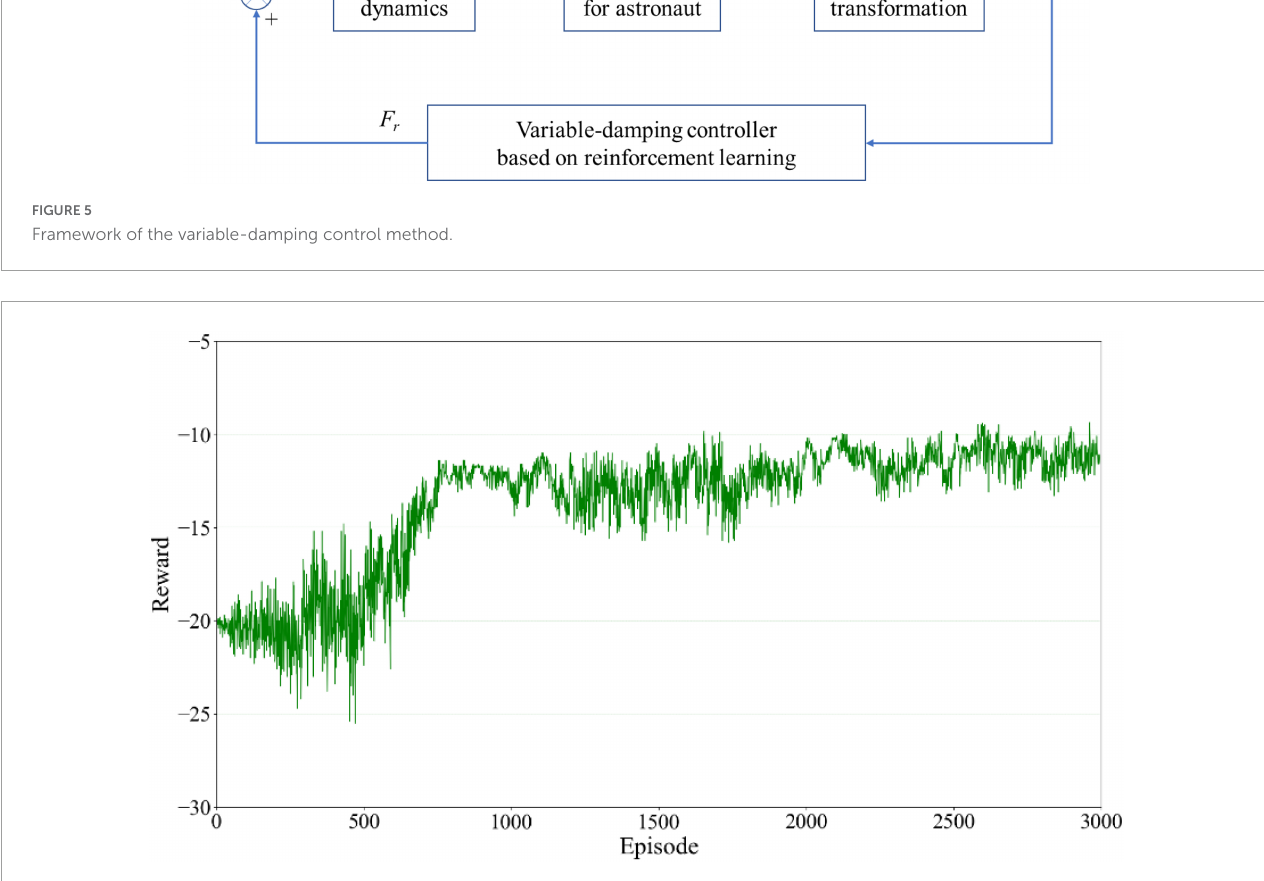
FIGURE6 Reward value of each episode for the agent.